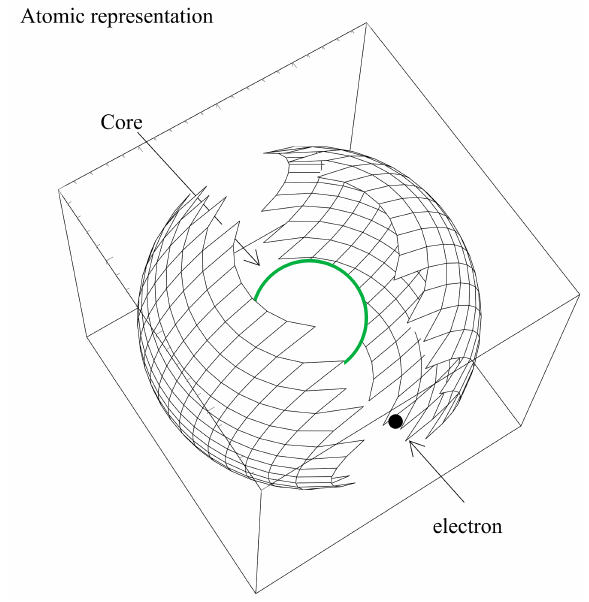
Figure 2. Contour surface of an atom where an electron can be.